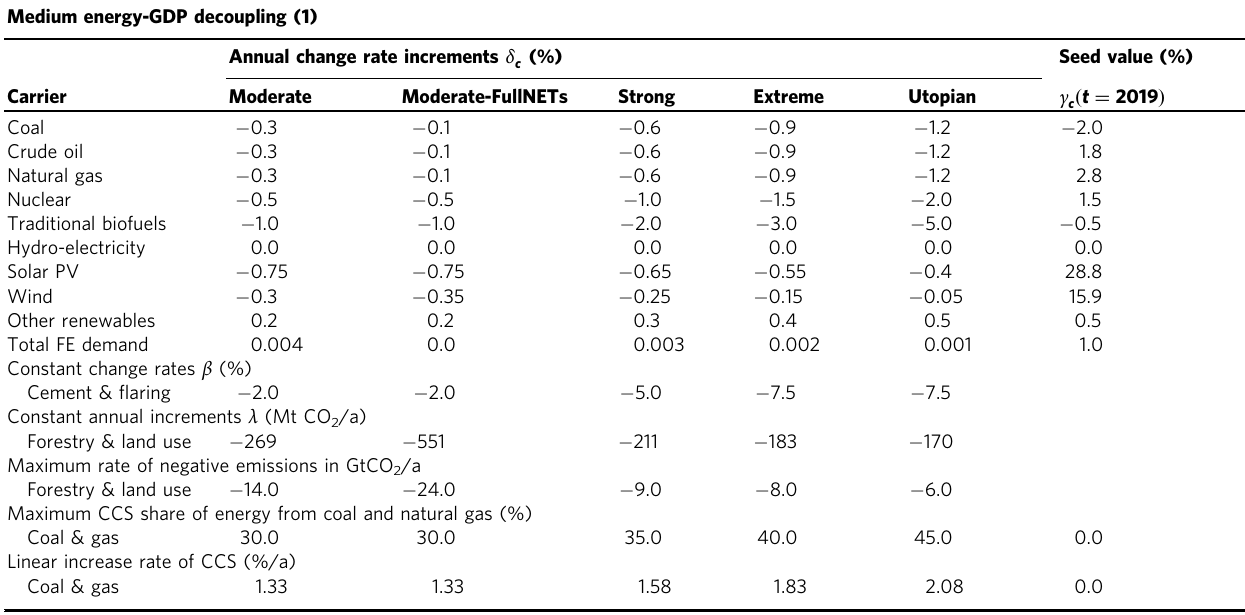
Table 4 Parameters for pathways with medium energy-GDP decoupling